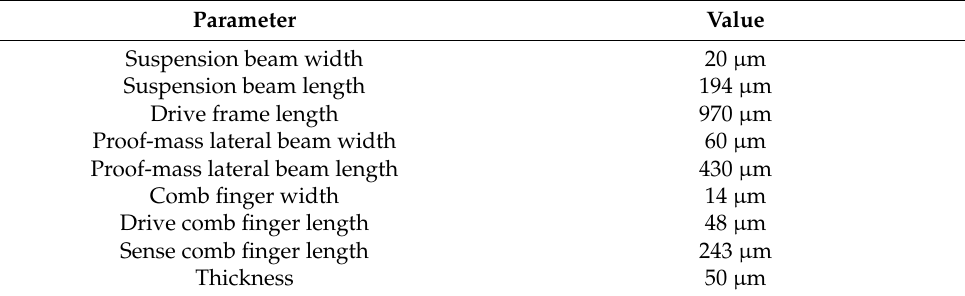
Figure 8. ( a ) Mass-spring-damper model of MEMS gyroscope design; ( b ) linear vibratory MEMS gyroscope design [22]. Table 3. Initial geometric parameters of MEMS gyroscope.